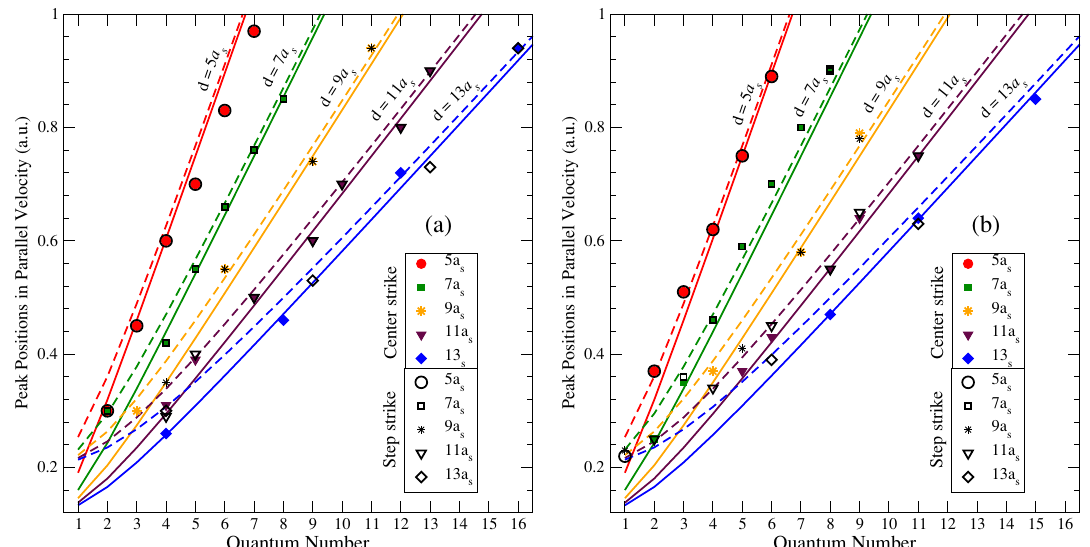
Figure 11. Same as Figure 9, but for Pd(111) vicinal